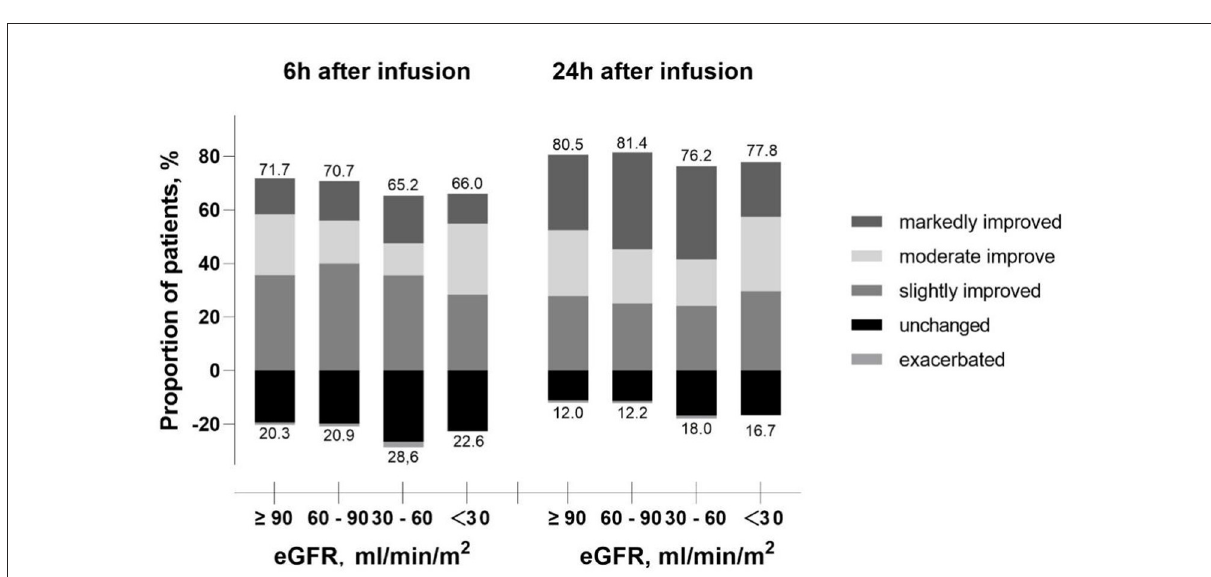
FIGURE2 Proportion of patients improved or exacerbated over infusion time according to the eGFR level. eGFR, estimated glomerular filtration rate.